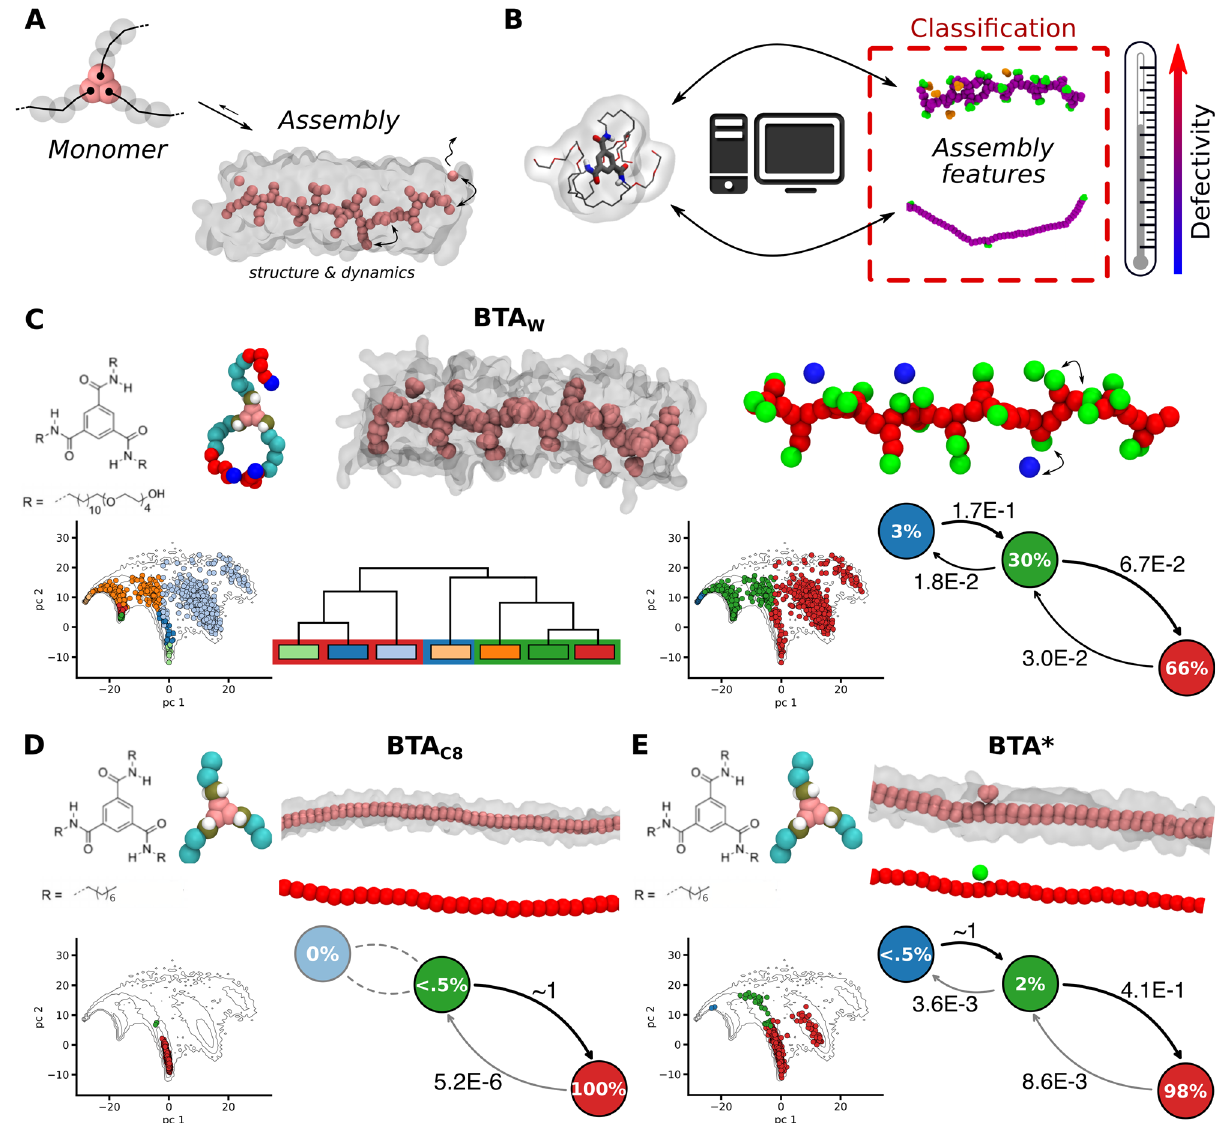
Fig. 1 Classi fi cation of supramolecular polymers based on the structural/dynamical features of their molecular motifs. A Scheme showing an example of monomer self-assembling into supramolecular 1D fi bers having a characteristic level of order/disorder which determines its structural/dynamical features (e.g., BTA) 6,7,34 . B A key question is how to design the monomers to obtain assemblies with controlled features. While ML techniques can be useful to this end, a fi rst necessary step is developing a classi fi cation approach to compare different supramolecular structures in an unbiased way. C Analysis of the water-soluble BTA W fi ber. Top-left: chemical structure and CG model of BTA W monomers, and equilibrium CG-MD snapshot of a BTA W fi ber 6,7,34 . Bottom-left: PCA scatter-plot of molecular motifs identi fi ed via SOAP + PAMM (projected on the fi rst two PCs: PC1 and PC2). Each color corresponds to a different motif detected in the BTA W fi ber (the underlying contour plot shows the distribution of all SOAP vectors sampled in the three compared BTA fi bers). The dendrogram indicates how the various detected motifs (microclusters: smaller rectangles) relate to each other, and how these can be merged into higher-level motifs (macroclusters: red, blue, and green larger rectangles). Top-right: coloring of monomer centers in an example equilibrium CG-MD snapshot based on the identi fi ed macroclusters. Bottom-right: PCA scatter-plot projection for BTA W colored based on the identi fi ed macroclusters. Right: dynamic interconversion diagram, reporting the relative probability of transition between various macrostates, and the relative state population. D , E Analogous SOAP + PAMM characterization for the BTA C 8 ( D ) and BTA * ( E ) fi bers based on the identi fi ed